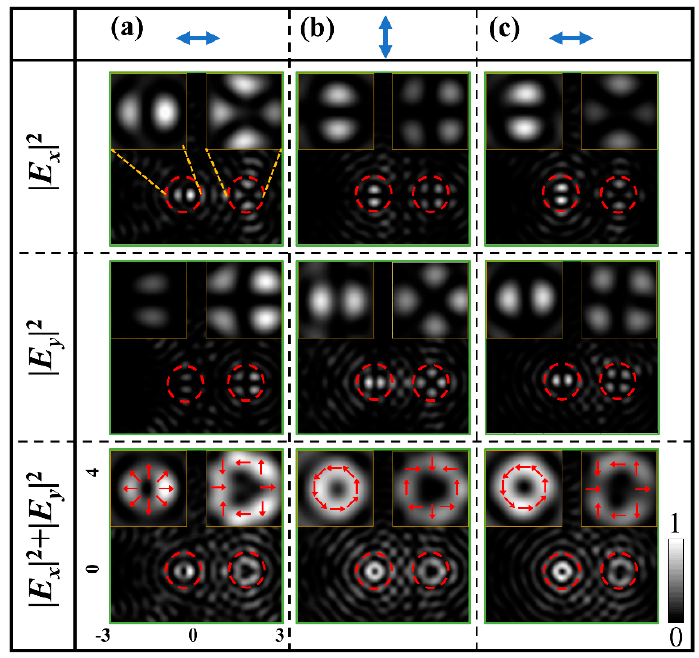
Figure 5. The intensity patterns of the dual VBs with different polarization states. ( a ) The radially polarized VBs with order l R = 2 and l L = 1. ( b ) The azimuthally polarized VBs with order l R = 2 and l L = 1. ( c ) The azimuthally polarized VBs with order l L = 1 and the radially polarized VBs with order l R = 2. From top to bottom, the intensity patterns are I = | E x | 2 , | E y | 2 and | E x | 2 + | E y | 2 of the two separated VBs. The insets are the enlarged views. The overlaid arrows show the schematic polarization states. The double arrows represent the linear polarization of illumination light.